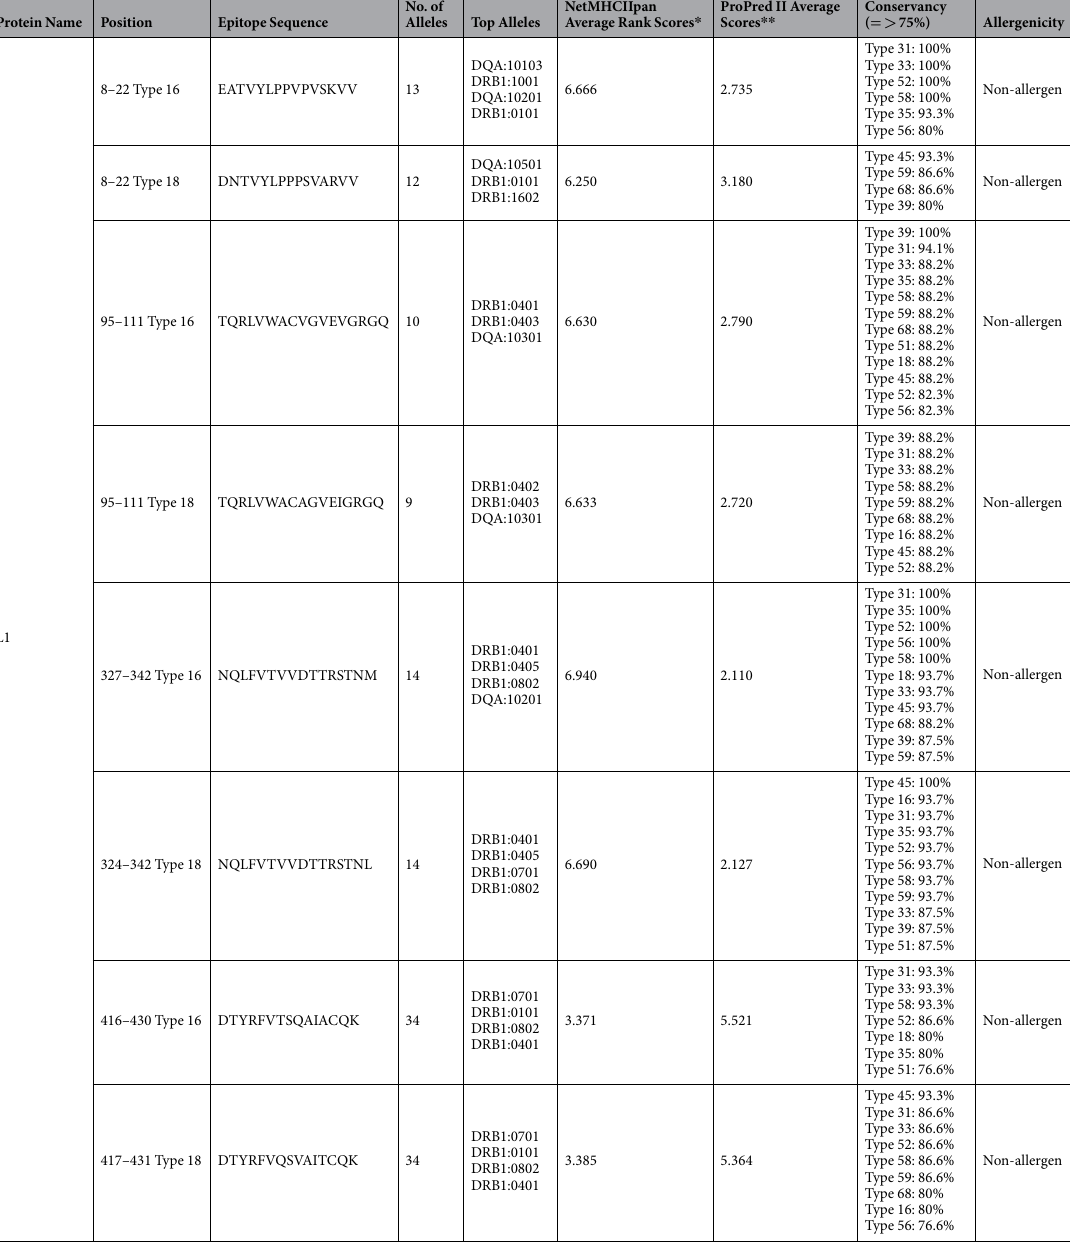
Table 6. The selected helper T Cell epitopes of HPV L1 protein based on binding affinity. * lower rates show better binding affinity, ** Higher rates show better binding